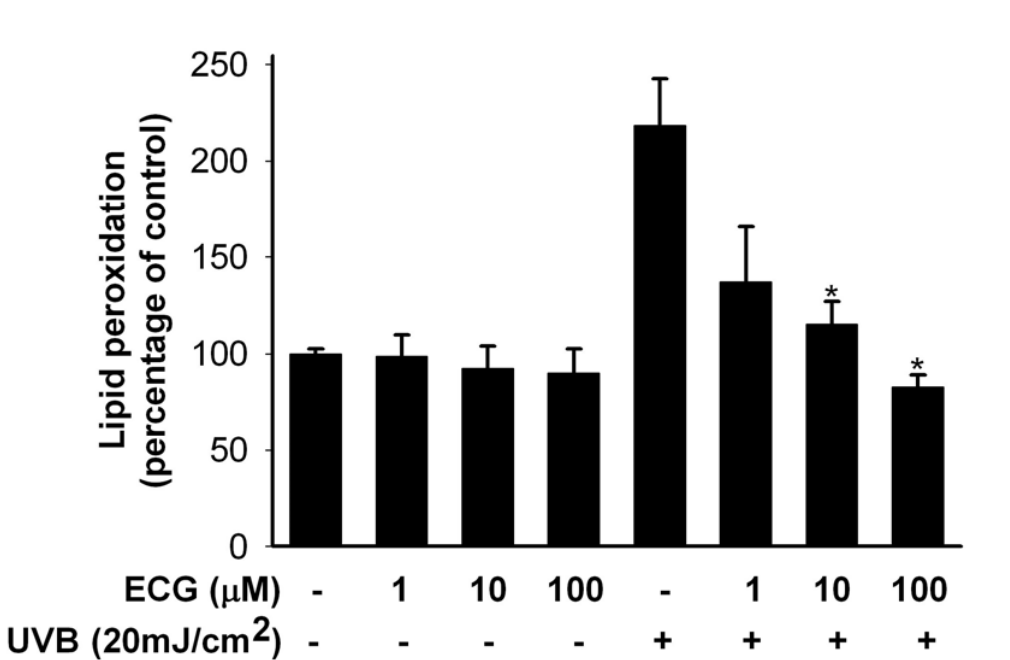
Figure 2. Protective effect of ECG on UVB-induced lipid peroxidation in human